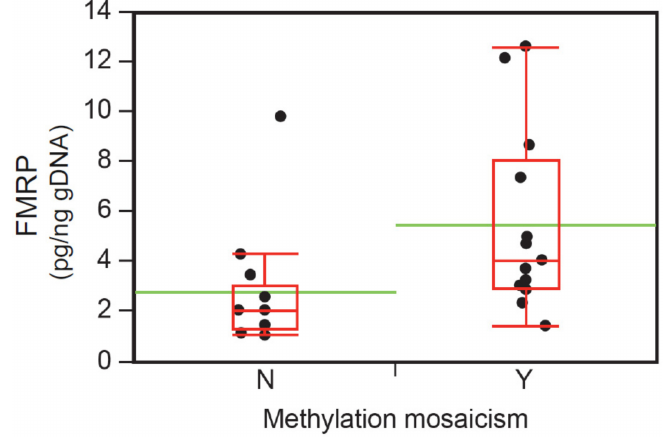
Figure 5. FMRP levels and methylation mosaicism (MM) status from whole blood specimens. In the FM–FMRP Subcohort males (N = 26), those with MM (Y) had significantly higher FMRP levels as measured by the qFMRP assay. One-way ANOVA ( p = 0.02), where the green line shows the mean for each group, and box plots represent the median and quantiles. Y (yes), N (no) methylation